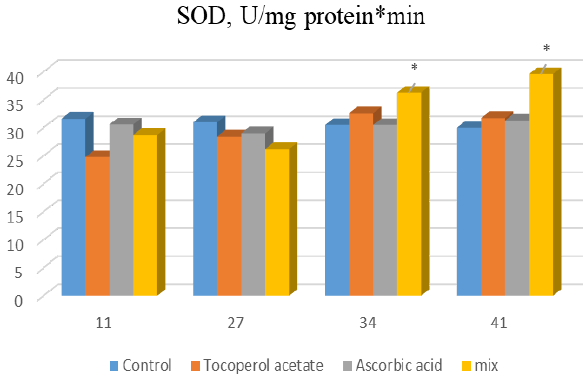
Fig. 2. Superoxide dismutase activity of blood erythro- cytes of broiler chickens (М ± m; n = 5) Both alone and combined use of vitamins E and C caused an inhibitory influence on the intensity of the